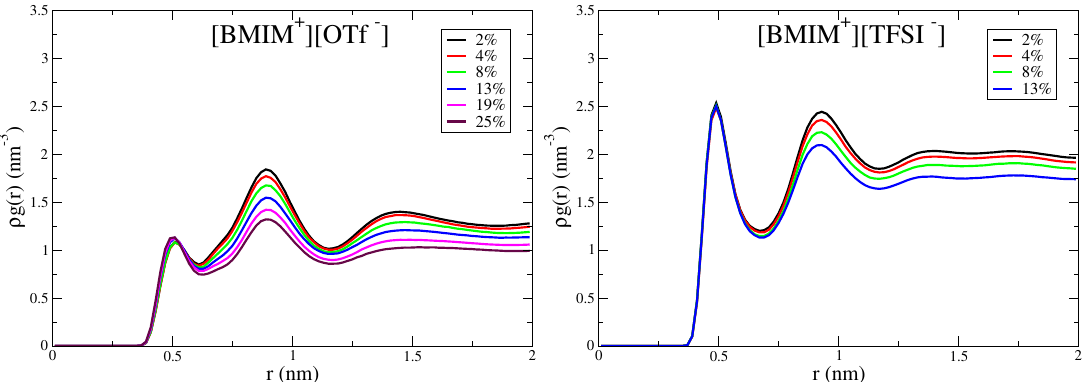
Figure 6. Anion/anion pairwise distributions computed from carbon atoms of -CF 3 groups for [BMIM + ][OTf − ]and [BMIM + ][TFSI − ]water mixtures. Distributions are normalized by the density of anion carbon